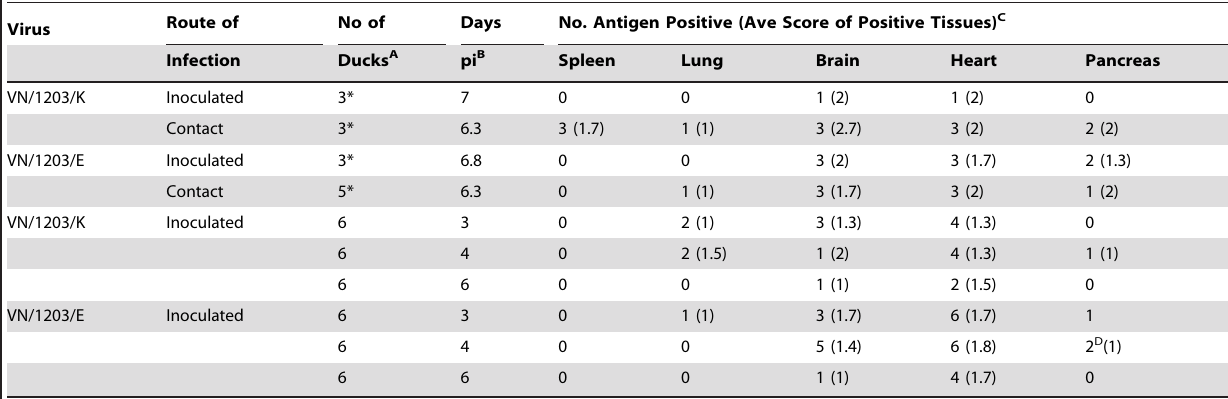
Table 3. Presence of viral antigen in ducks infected with HP VN/1203/K and HP VN/1203/E virus.